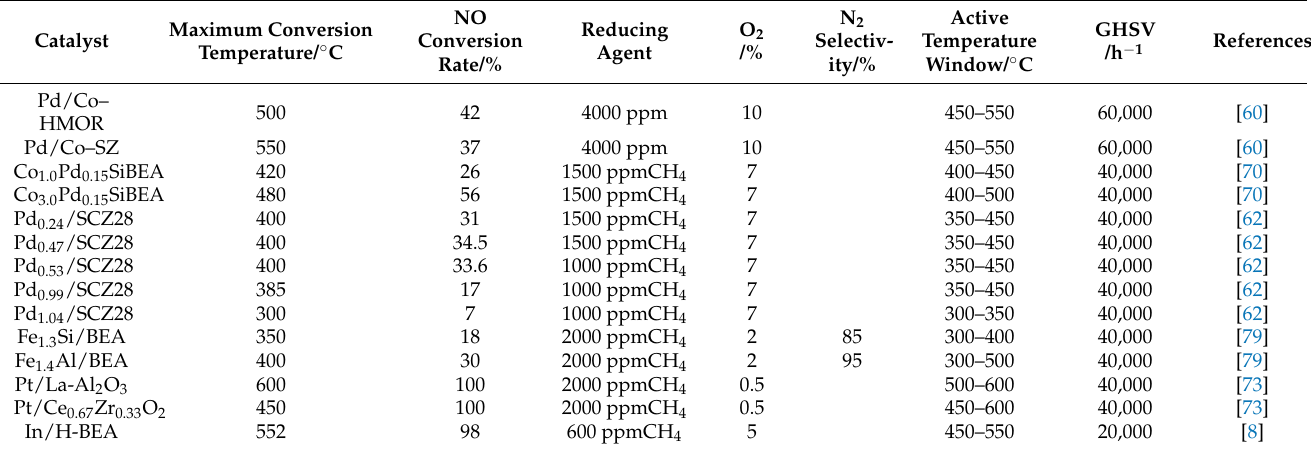
Table 2. Catalysts for catalytic reduction of NO x by CH 4 under different conditions.